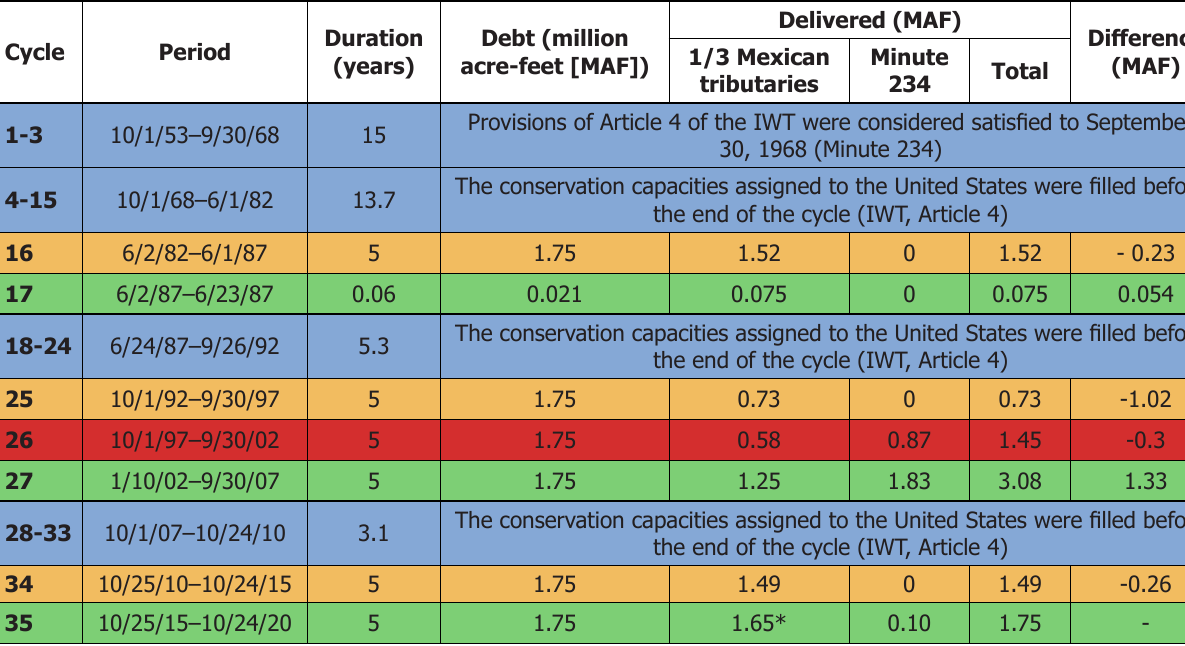
Color description: blue - the terms of the 1944 water treaty were met before or at the end of the cycles; orange - cycles with a deficit at the end; green - previous cycle debt was paid off; red - two successive cycles with deficit. *Included 0.06 MAF through Minute